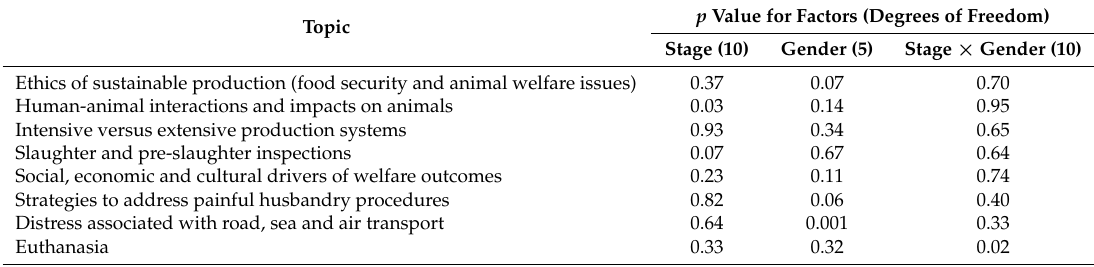
Table 2. p values obtained from log-linear model on the effect of gender and stage of course on scores to each question, and the interaction of the two factors. p values < 0.05 appear in bold font.